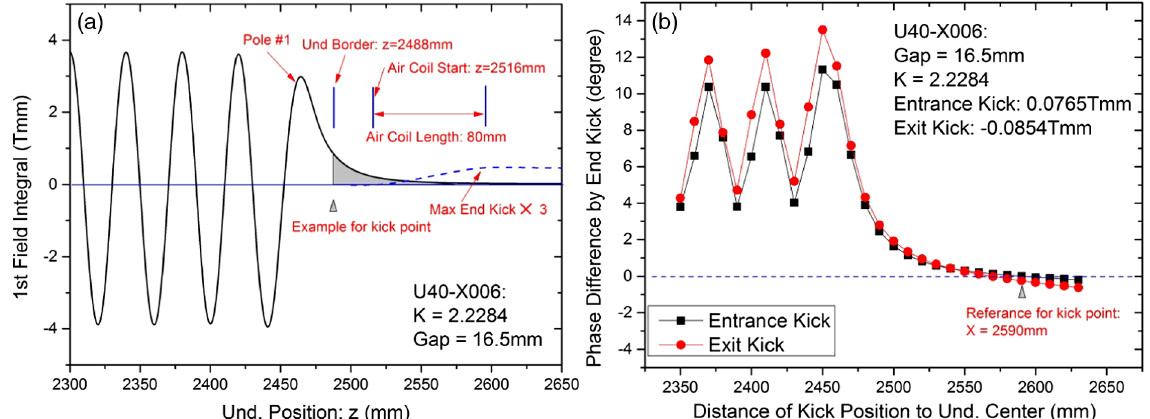
FIG. 5. Effect of the position of the air coil on optical phase. (a) First field integral of the U40-X006 undulator. The hardware border for both undulator and air coil positions are indicated. For demonstration the dashed line indicates the contribution of the air coil with full excitation of 0.45 Tmm (b) Dependence of the phase difference on the position of the air coils at the entrance (black squares) and exit (red circles). Note the abscissa represents the distance to the center not the X-position.